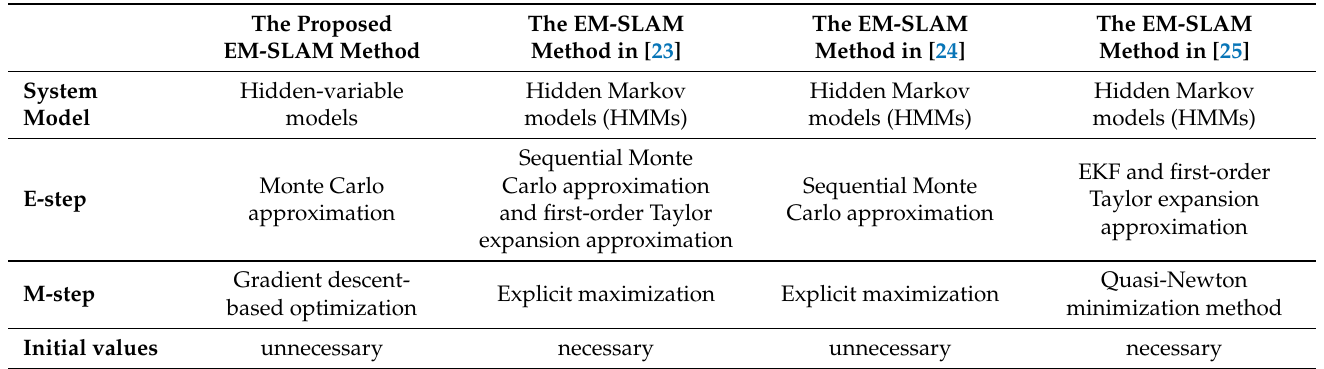
Table 1. Comparison between EM-SLAM